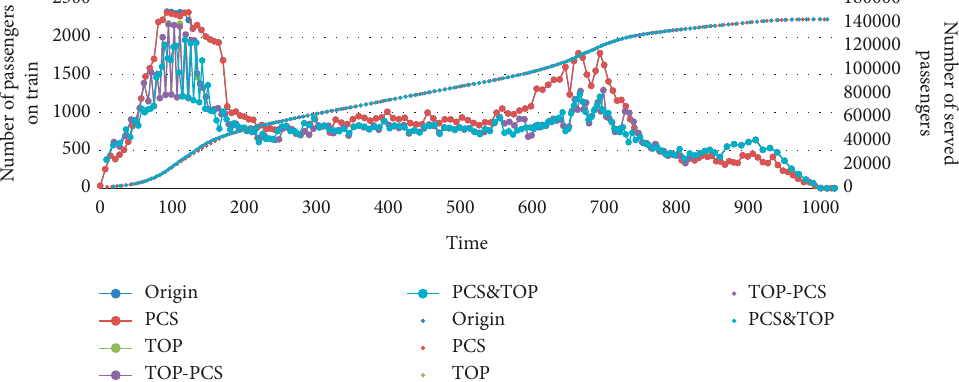
Figure 16: Number of loading passengers at each train on Line 4 in different solutions.